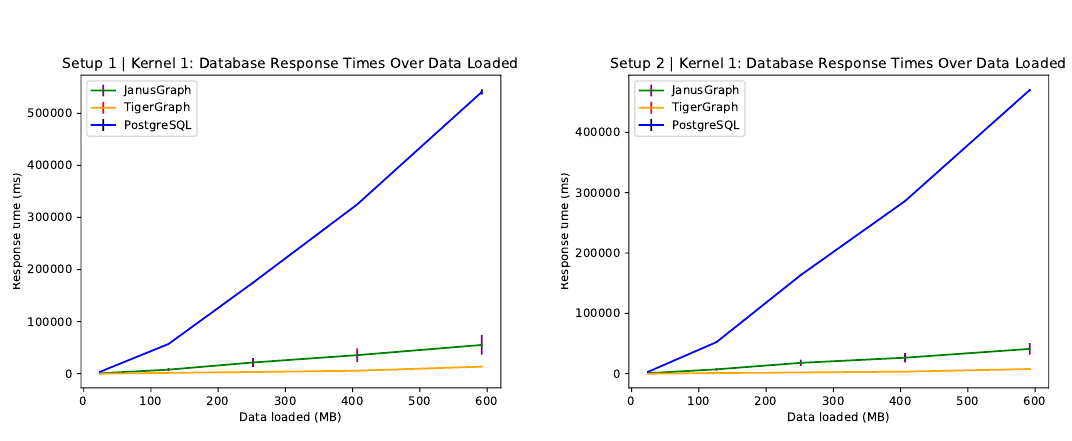
Figure 5. Database response times over varying percentages of the dataset for setup 1 and 2 for the kernel: “Kate’s Restaurant Recommendation”. The error bars display standard deviation.